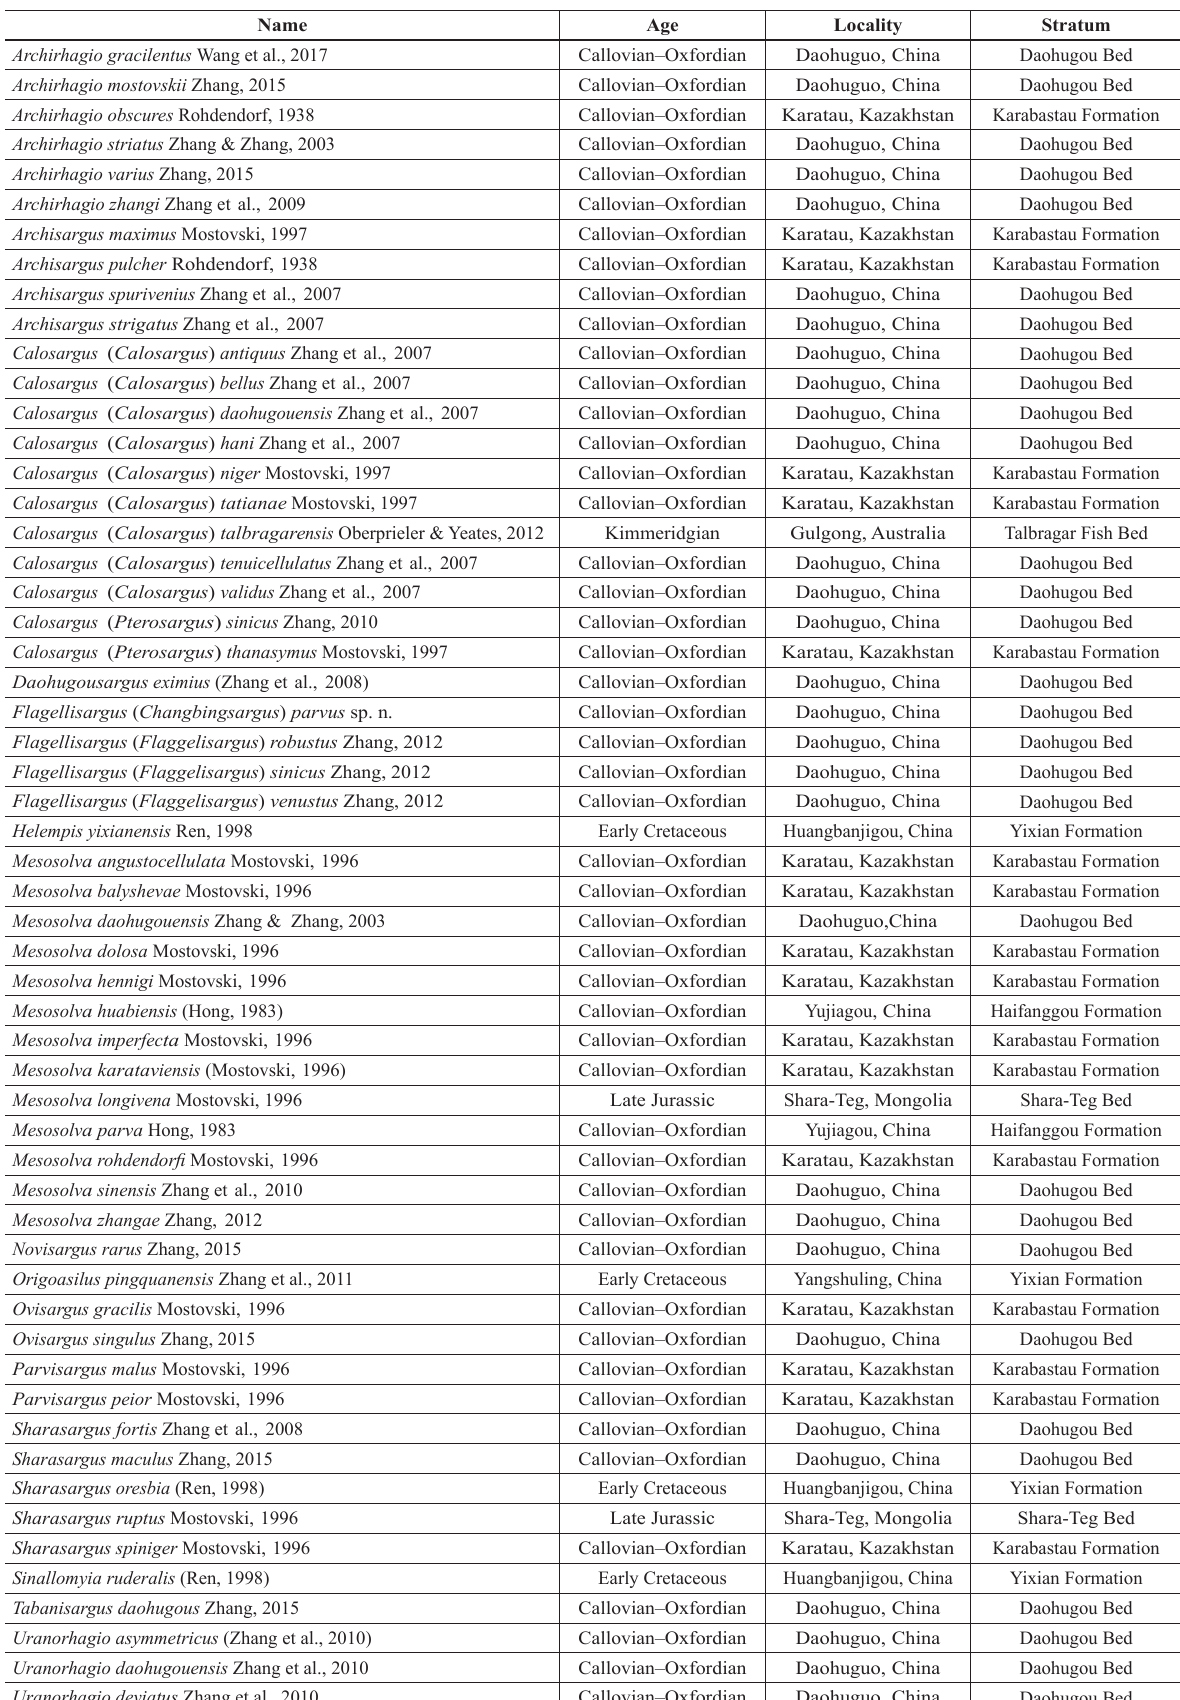
Table 1. Species of Archisargidae with ages, localities and strata